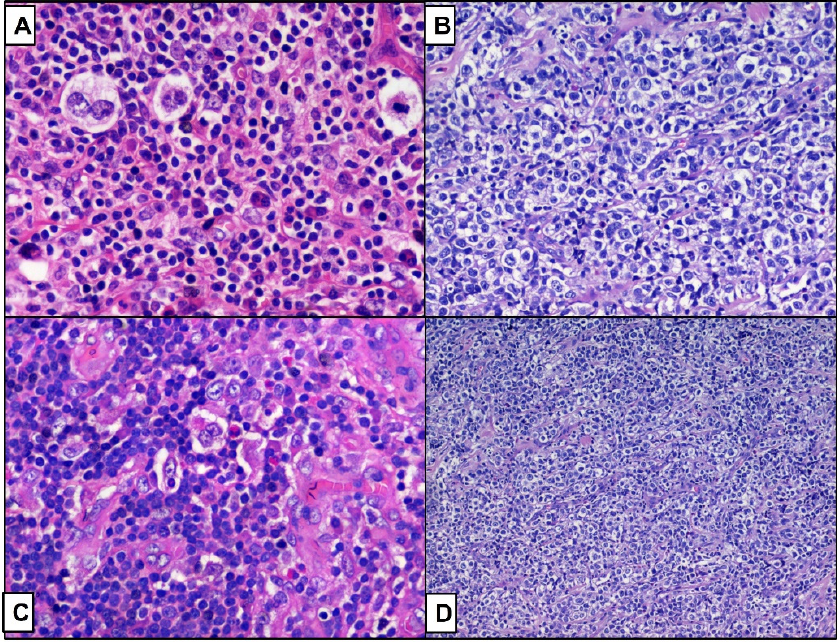
Figure 3. Histological comparison between cHL ( A – C , hematoxylin-eosin, original magnification 200×) and DLBCL (B-D hematoxylin-eosin, original magnification 200× and 100×), in the patient respectively 2 ( A , B ) and 4 ( C , D ). in the patient respectively 2 ( A , B ) and 4 ( C , D